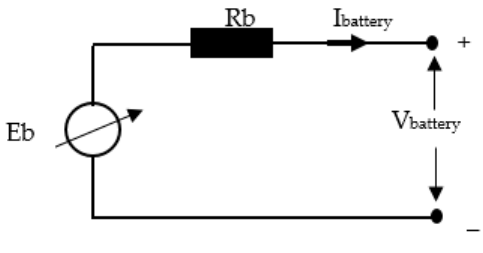
Figure 9. Equivalent battery circuit.